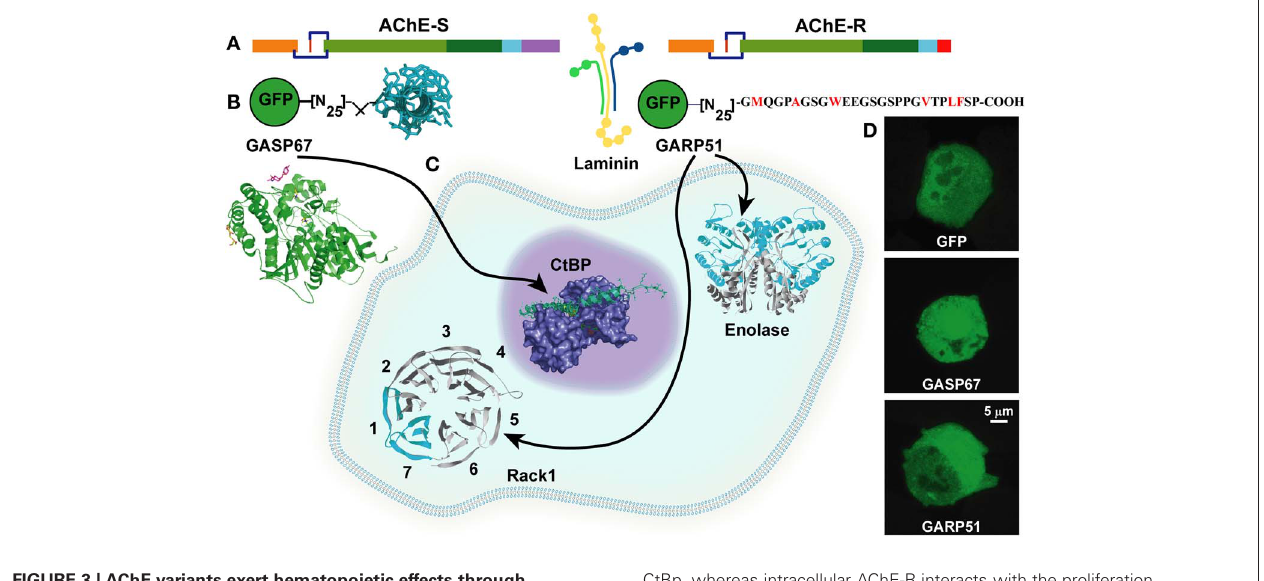
FIGURE 3 | AChE variants exert hematopoietic effects through common and distinct protein partners. (A) The common core domain of AChE interacts with laminin. (B) To validate partner interactions, the C-termini of AChE-S and AChE-R were constructed together with GFP. (C) The C-terminus of AChE-S interacts with the anti-apoptogenic nuclear